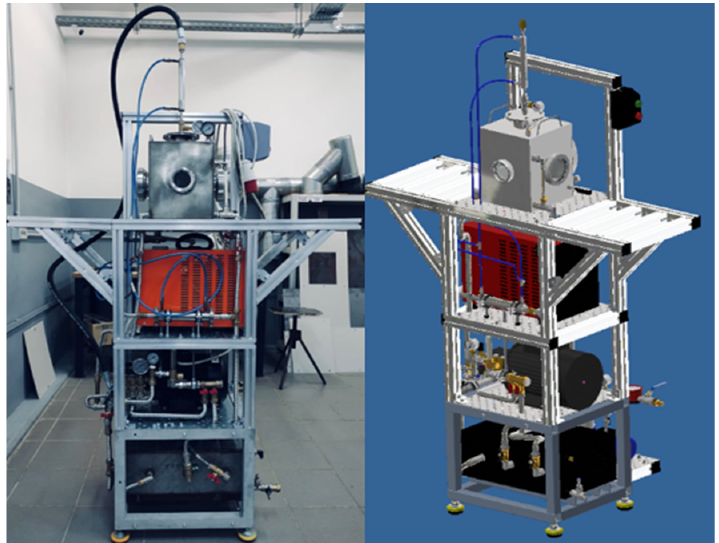
Figure 2. Appearance and sketch of cavitation jet test rig.